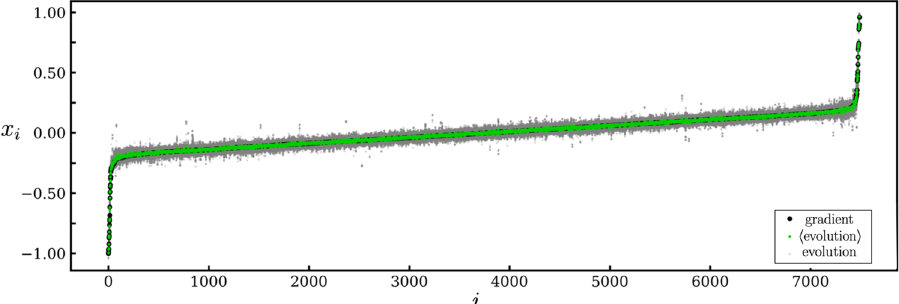
Fig. 4 Numerical illustration of correspondence for a deep net. We show all 7489 parameters x i of the deep net of Fig. 3 at training time t = 5. As predicted analytically, the neural network created by averaging (green symbols) over a noninteracting population of neuroevolutionary processes (gray symbols) is essentially the same network as that produced by gradient descent (black symbols). For clarity, weights are ordered by their fi nal values under gradient descent.